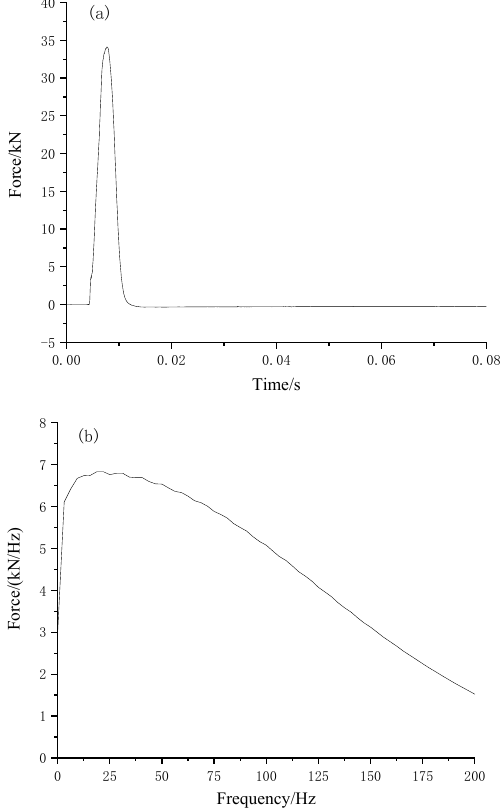
Figure 7. ( a ) Time history and ( b ) Fourier spectrum of the impact load . Figure 8 illustrates time history and frequency spectrum of measured results of two test conditions.